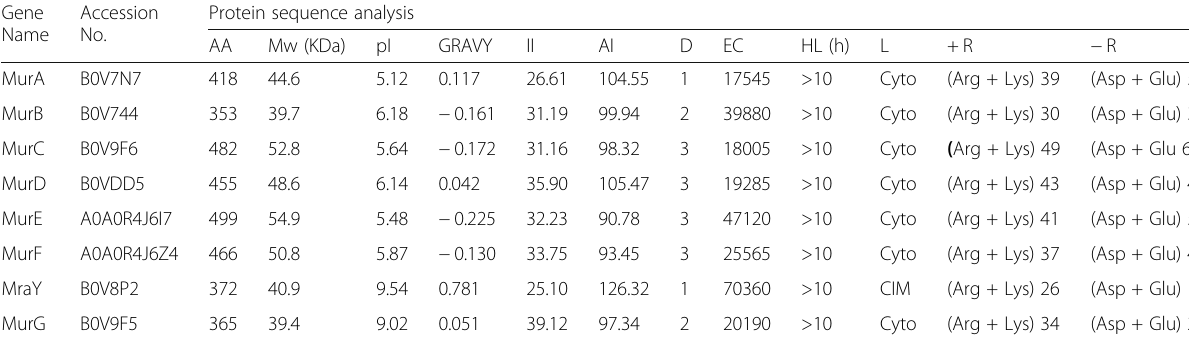
Table 2 The primary protein sequence analysis of eight Mur family proteins from A . baumannii Gene Accession Name